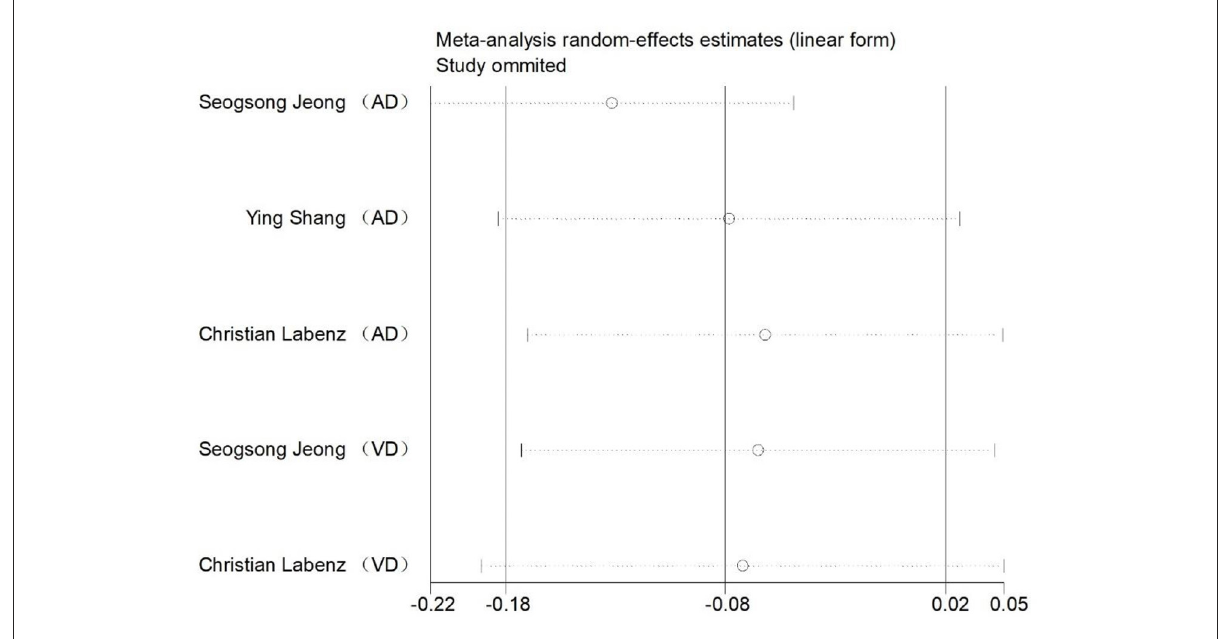
FIGURE5 Sensitivity analysis of the risk of AD and VD caused by NAFLD.